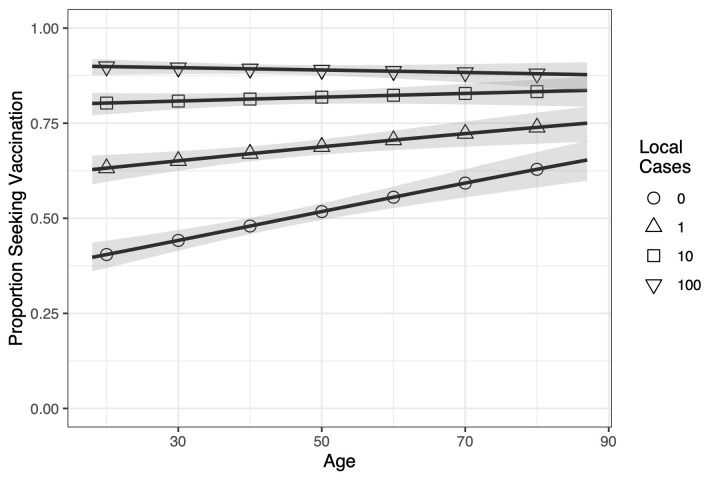
For each level of risk, we plot the proportion of respondents willing to seek vaccination across ages.Younger populations vary more in proportion willing to seek vaccination than older ones, i.e., when risk is lowest (0 local cases) the young have the lowest proportion, but when risk is highest (100 local cases) the proportion is at least as high for the young as the old. This illustrates a key idea behind vaccine propensity: some populations are more responsive to changes in risk than others. The solid lines are the trend lines, and the shaded area is the 95% prediction interval.